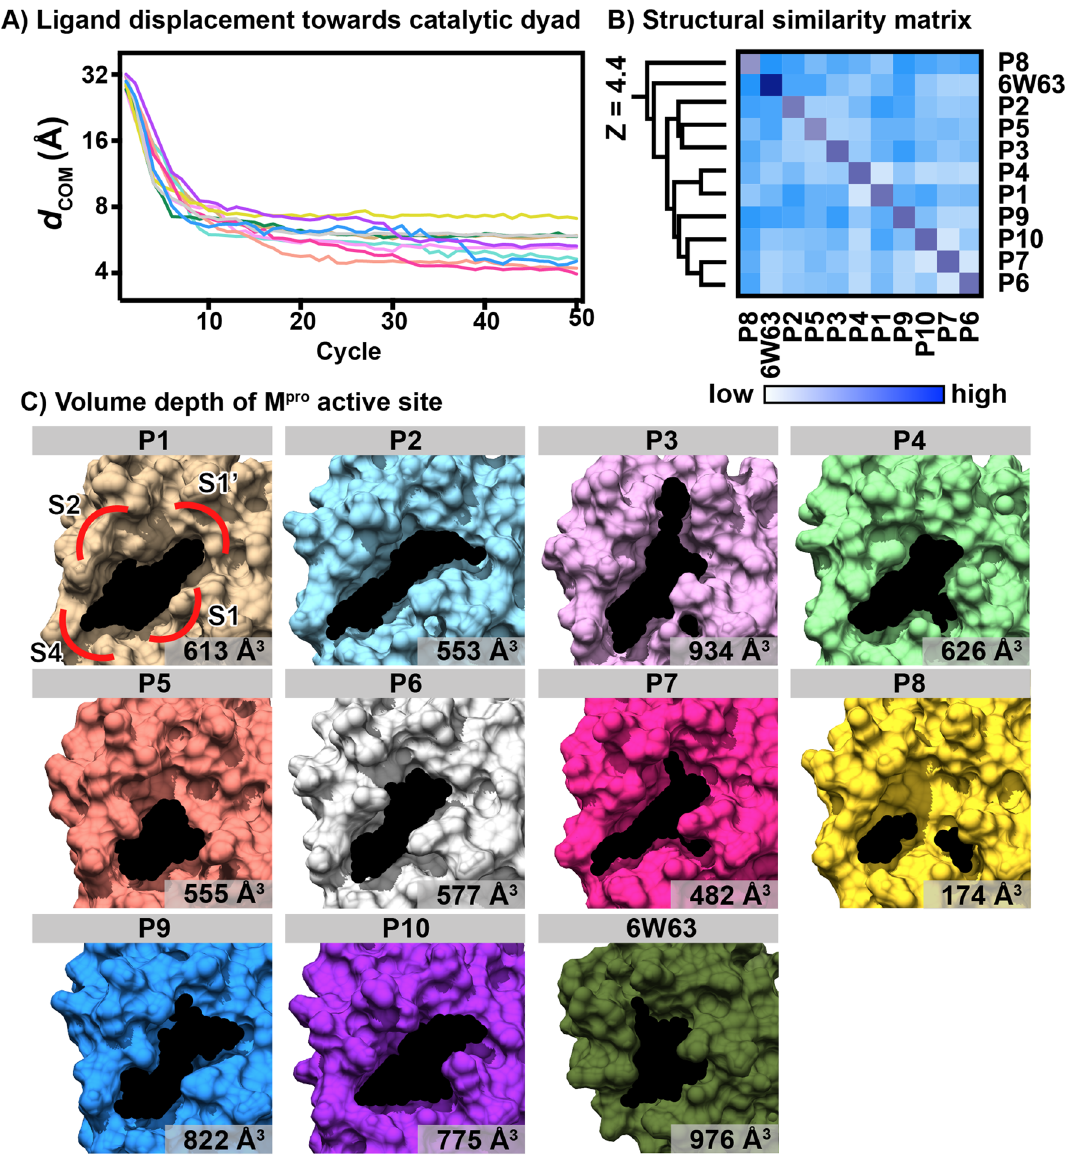
Figure 5. ( A ) Distance between the ligand and H41–C145 catalytic dyad centres of mass ( d com ) plotted for 50 LB-PaCS-MD cycles. ( B ) Pairwise structural alignment is consistent with the ligand-binding pocket at M pro active site. ( C ) Corresponding volume depth compared to that of the SARS-CoV-2 M pro /X77 complex (6W63) crystal